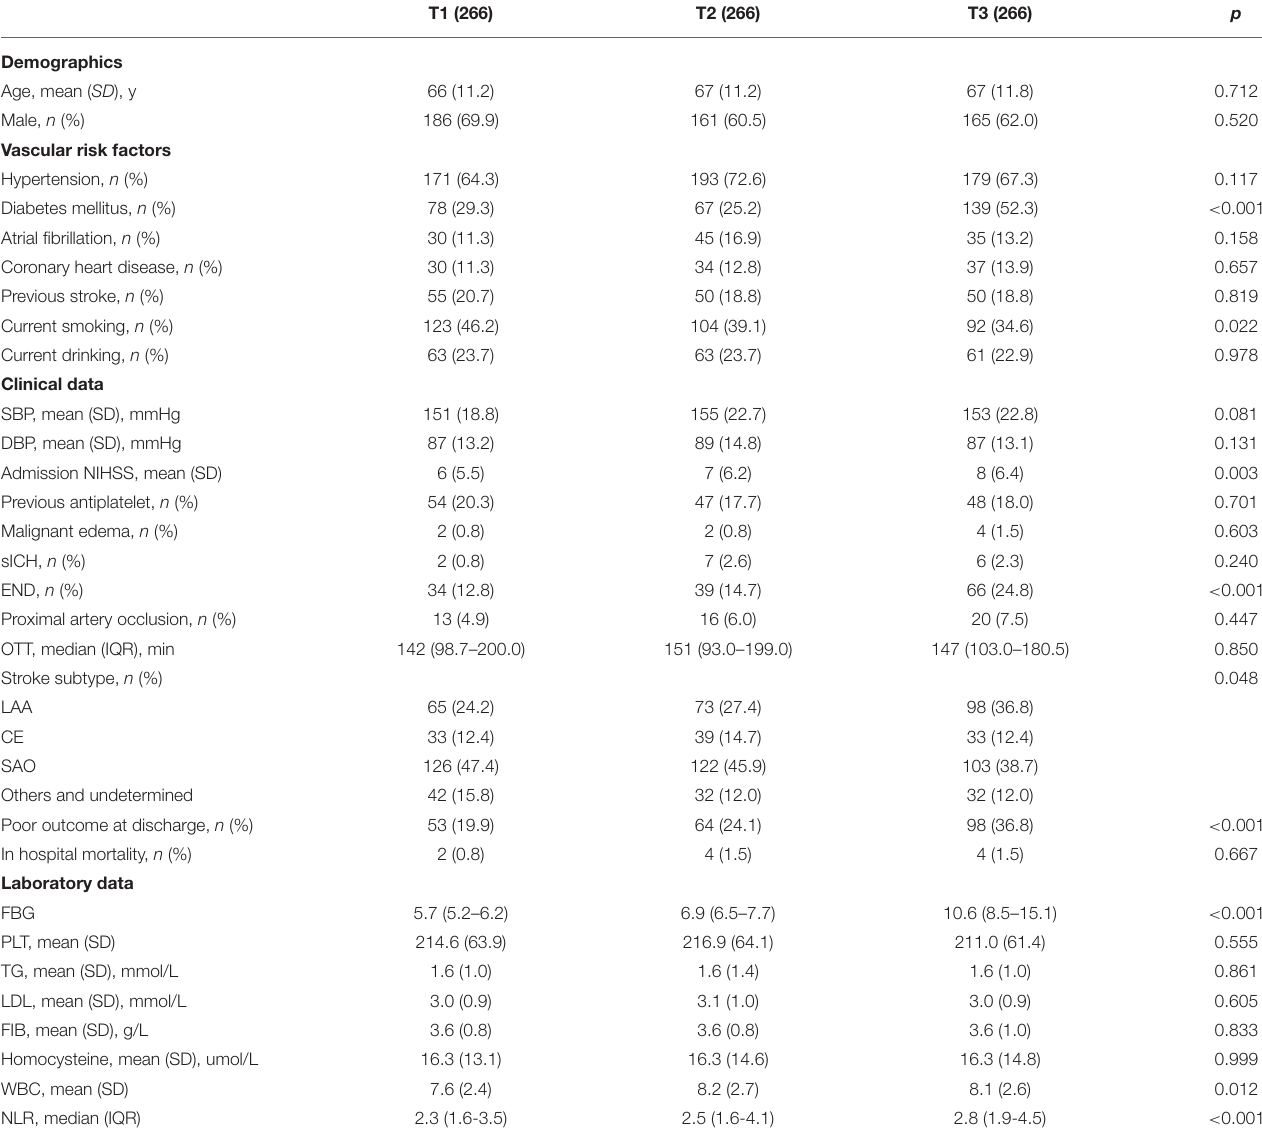
TABLE 2 | Baseline characteristics of subgroups based on SHR